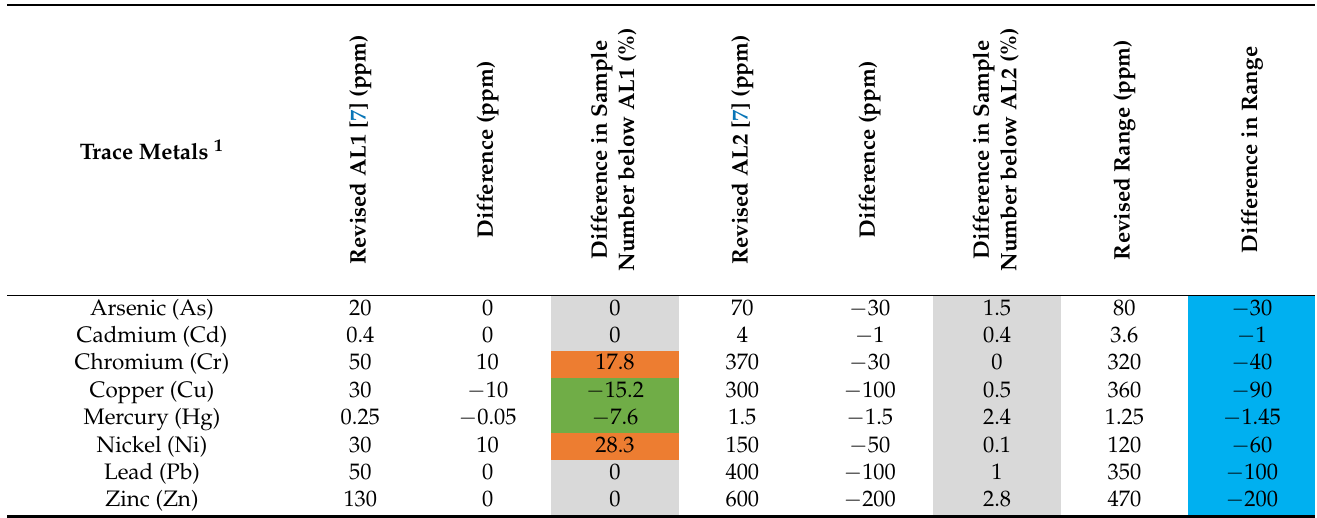
Table 6. Trace metals—Difference (revised − current) in percentage of samples below AL1; above AL2 for revised ALs and range of values between AL1 and AL2. Please note values (green) are more protective and values (orange) are more permissive (colour codes defined in Tables 2 to